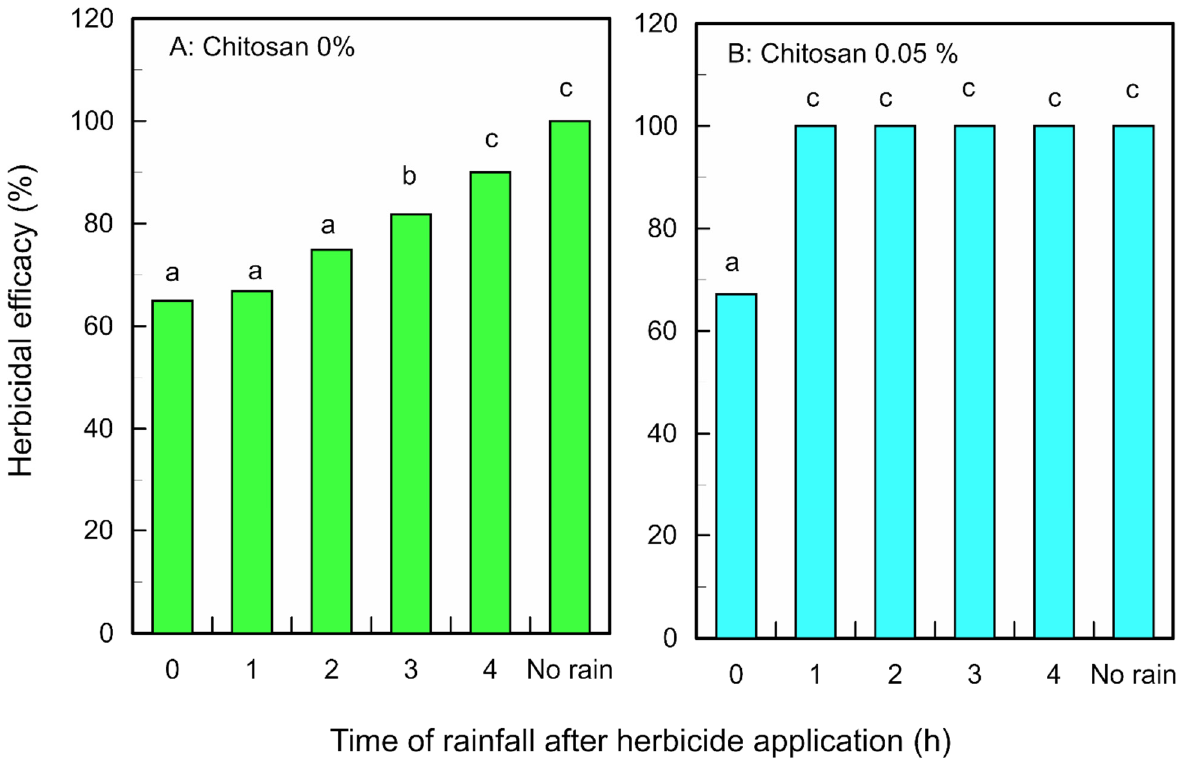
Figure 3. Effect of simulated rainfall at different time intervals after paraquat application on Paspalum conjugatum . ( A ): Chitosan 0%, ( B ): Chitosan 0.05%, Different letters show significant differences at the level of 5% according to Duncan’s test. Table 2. Effect of simulated rainfall on herbicidal efficacy of a mixture of paraquat and chitosan against Paspalum conjugatum at different time intervals after mixture application.